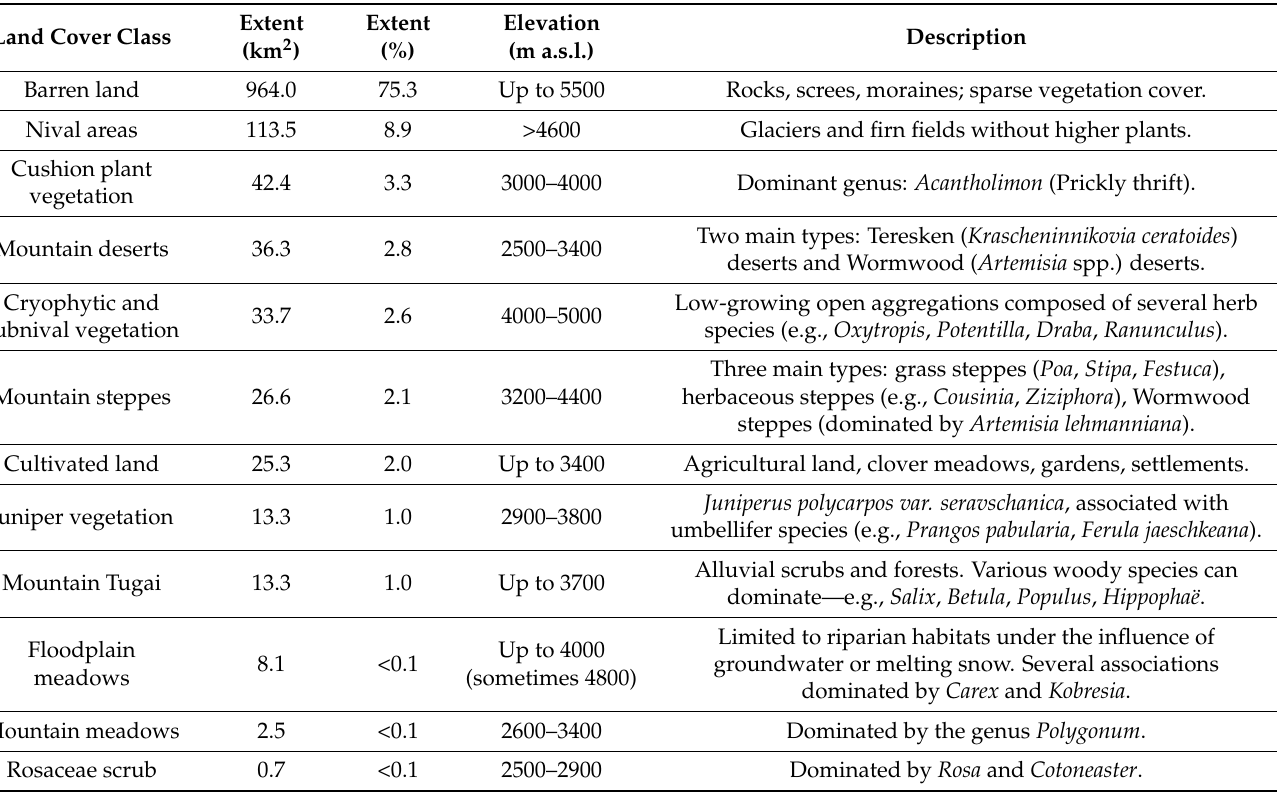
Table 1. Land cover classes of the study area (ordered from largest to smallest